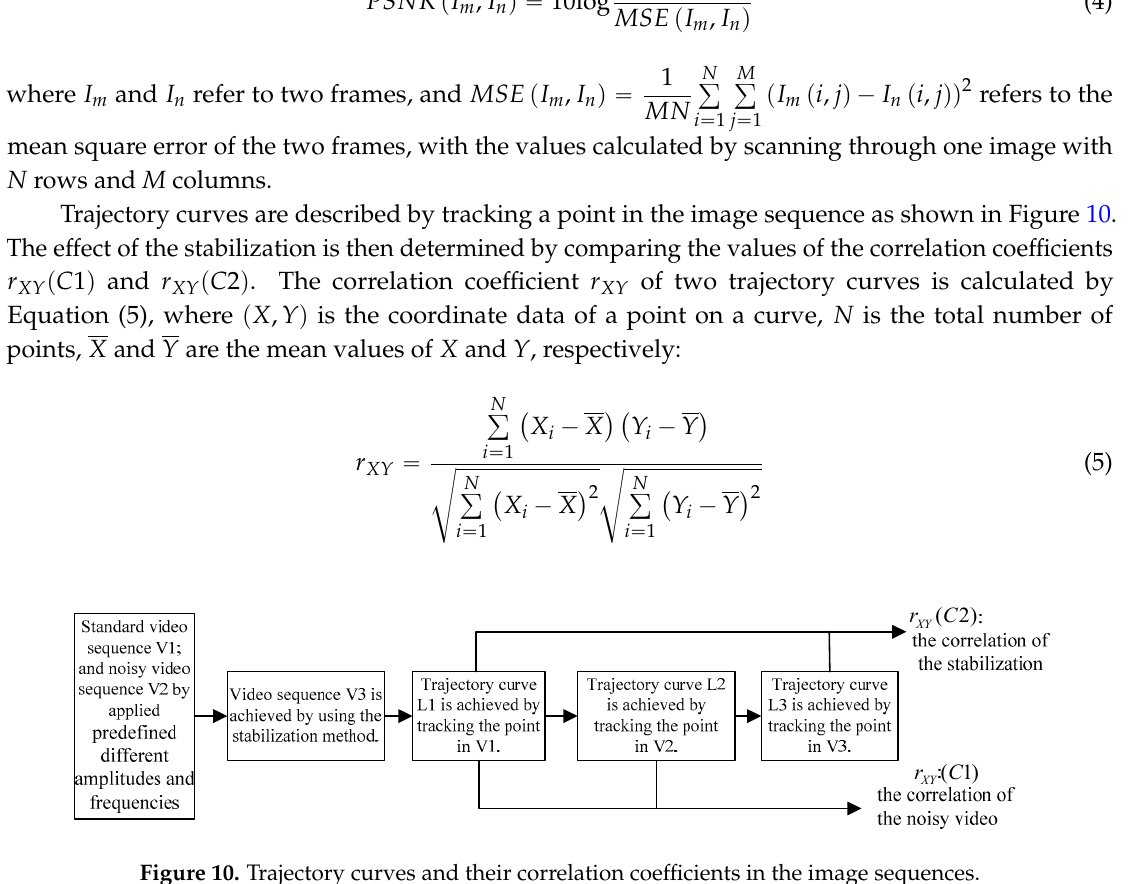
Figure 11. Application of the stabilization method.